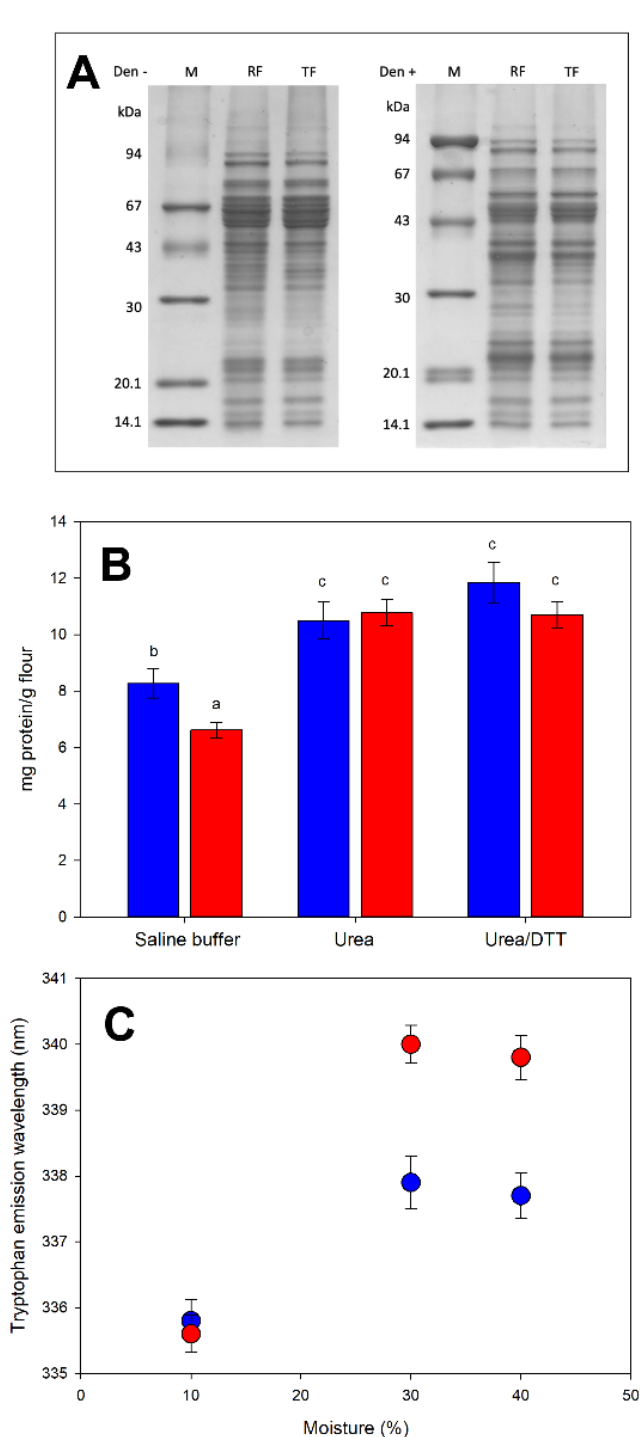
Figure 2. Protein properties. Panel ( A ): SDS-PAGE in non-reducing (Den − , left) and reducing (Den+, right) conditions; M: markers; RF: raw flour; TF: heat-treated flour. Panel ( B ): Protein differential solubility in non-dissociating (saline buffer), dissociating (urea), and reducing (urea/DTT) buffers for raw (blue) and heat-treated (red) flour. Samples marked with the same letter (a, b, c) are not significantly different ( p < 0.05). Panel ( C ): Tryptophan emission maximum recorded in front-face fluorescence upon kneading raw (blue dots) or heat-treated (red dots) flour with different amounts of water. DTT: dithiothreitol.